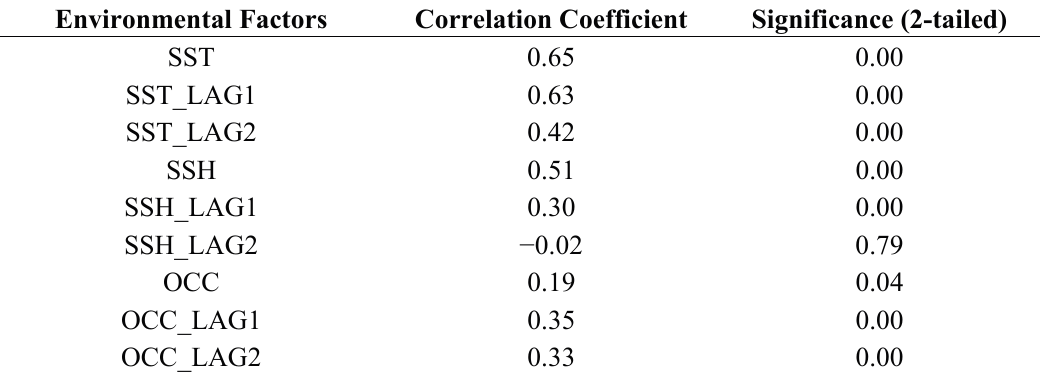
Figure 6. Time series of monthly cholera cases and OCC in Zhejiang Province, China during 1999–2008. Table 2. Relationships between cholera and satellite-derived environmental factors. SST_LAG1, SSH_LAG1 and OCC_LAG1 respectively represent one-month lag SST, SSH and OCC. SST_LAG2, SSH_LAG2 and OCC_LAG2 respectively represent two-month lag SST, SSH and